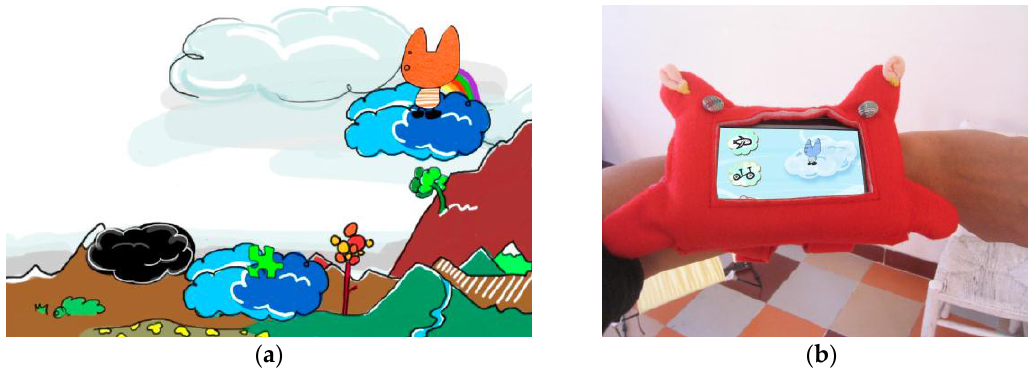
Figure 4. Video game example: ( a ) screenshot of the game Puzzle City; and ( b ) bracelet to hold a mobile device.